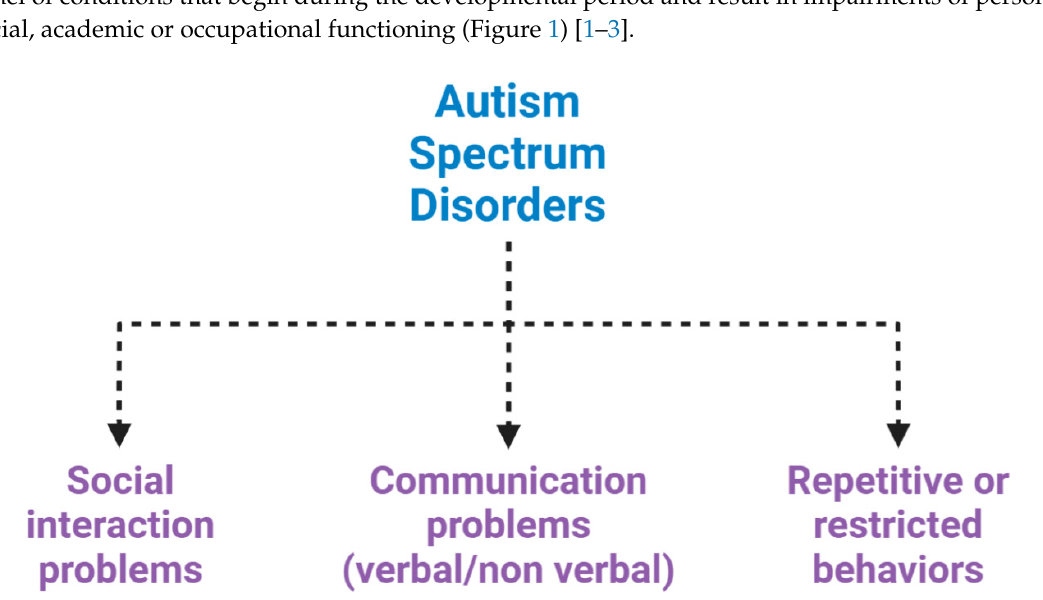
Figure 1. Neuropsychiatric features of autism spectrum disorder (ASD). ASD is characterized by impairments in social interaction, difficulty in adapting behaviour in various social contexts, or lack of interest in peers; communication problems, such as difficulty making eye contact, facial expressions, body postures, and difficulty understanding or using the gestures that regulate interaction with others; and restricted or repetitive behaviours, such as rituals that are conducted with a rigid manner or movements.